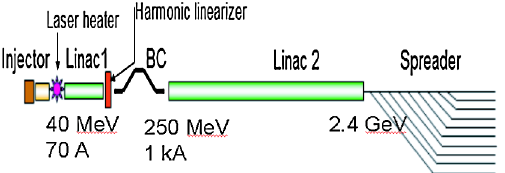
FIG. 9. (Color) A schematic plot of a proposed FEL linac at Berkeley.